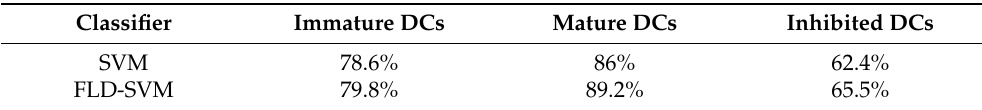
Table 4. Different classification rates obtained by the SVM and FLD-SVM classifiers on the considered experimental